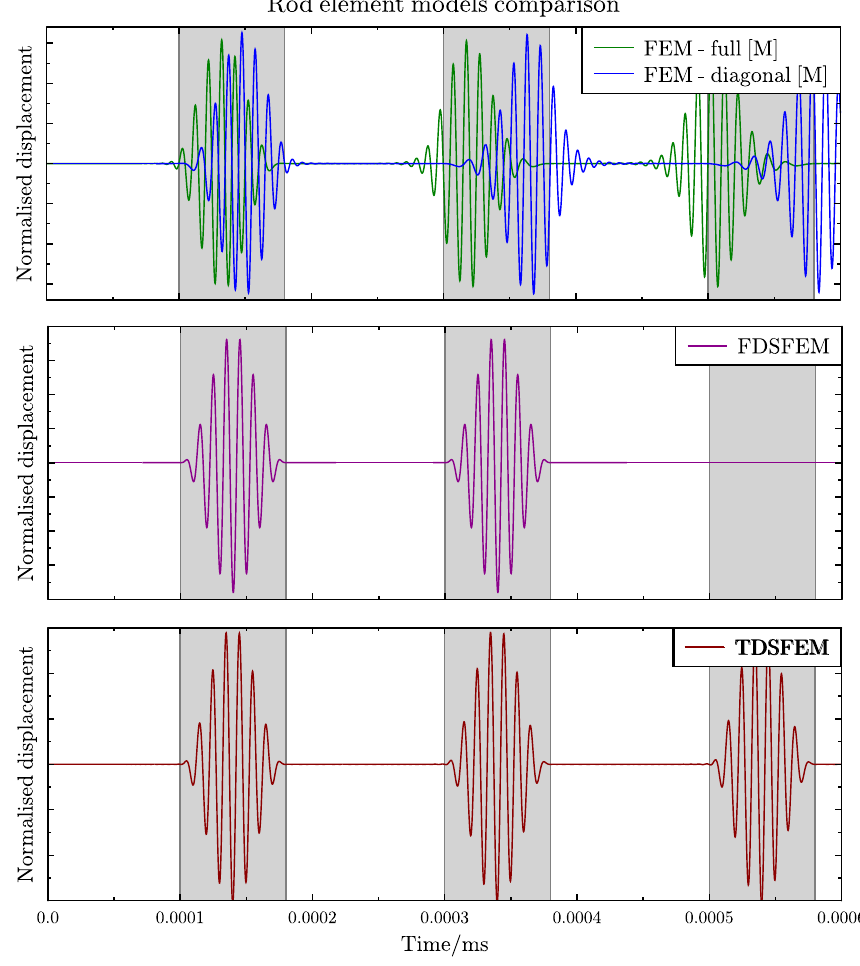
Figure 5. Errors resulting from numerical